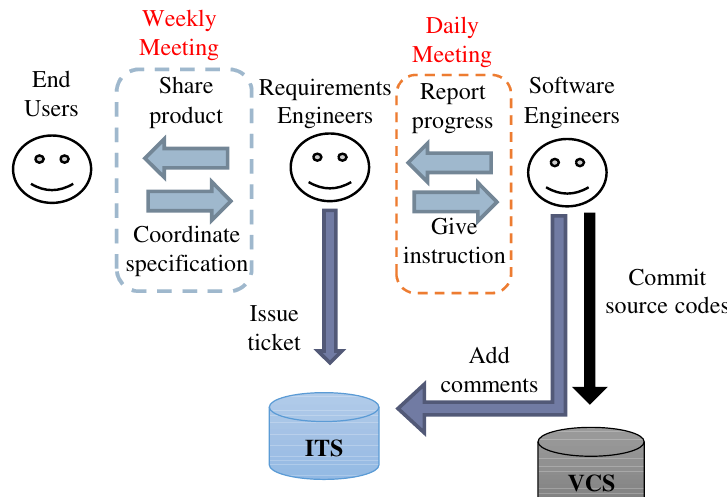
Figure 4. Actors and their communications in the case study.